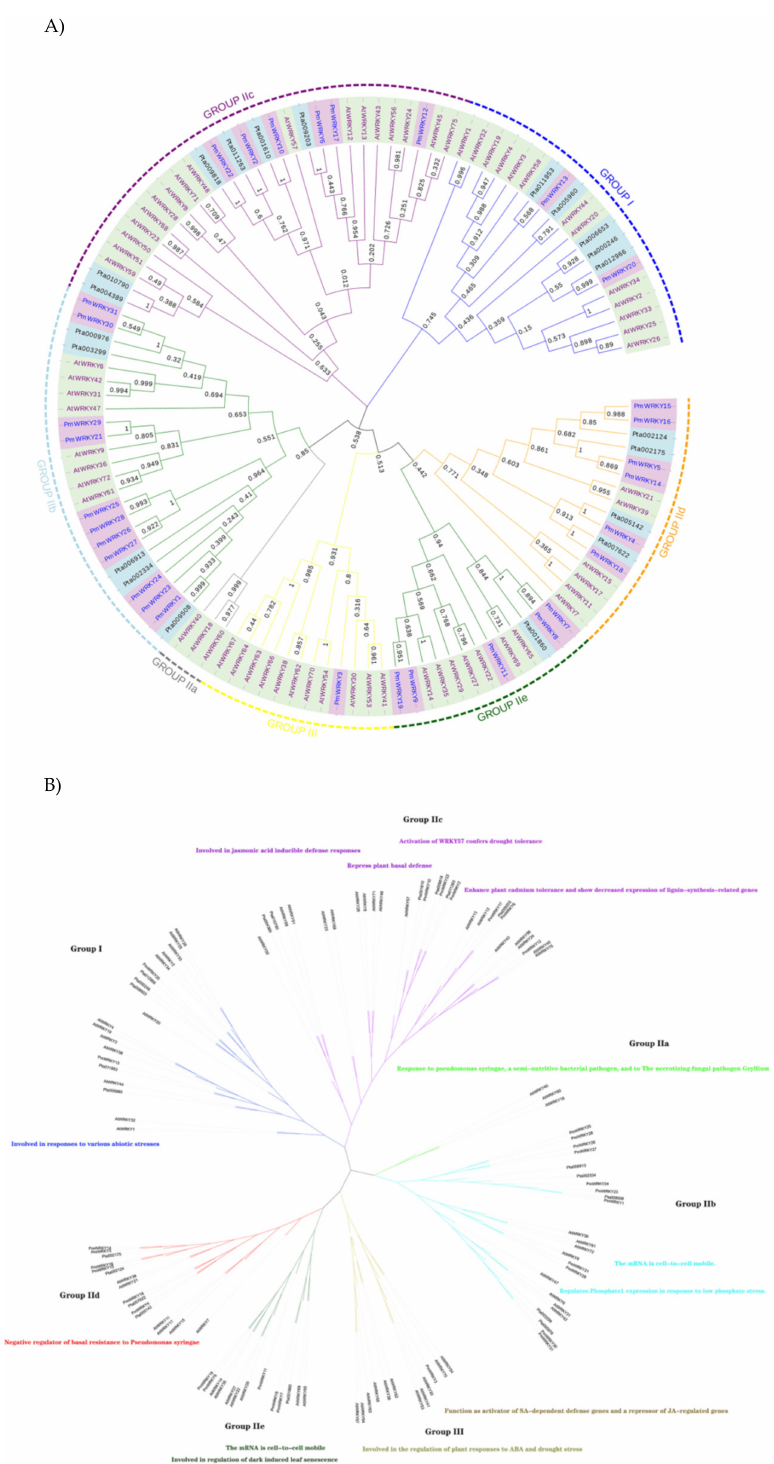
Figure 3. Classification of di ff erent groups of PmWRKY s, AtWRKY s and PtWRKY s. Di ff erent color branches and strips are used to distinguish di ff erent subgroups. In addition, the purple background is P. massoniana , the blue background is P. taede and the yellow background is A. thaliana. ( A ) The maximum likelihood method was used to analyze the evolutionary trees of 31 PmWRKY s, 65 AtWRKY s and 21 PtWRKY s. ( B ) The functions of each AtWRKY group marked in the evolutionary tree